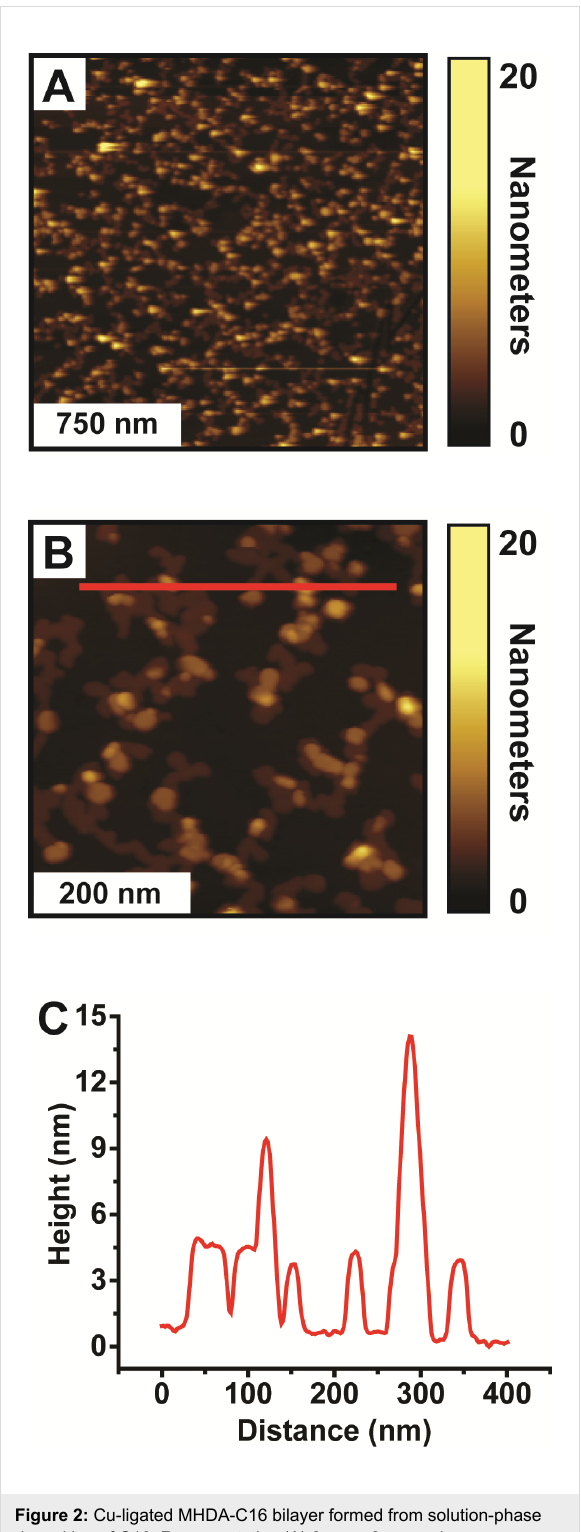
Figure 2: Cu-ligated MHDA-C16 bilayer formed from solution-phase deposition of C16. Representative (A) 2 µm × 2 µm and (B) 500 nm × 500 nm AFM images of a Cu-ligated MHDA-C16 bilayer formed from the solution deposition of MHDA for 18 h, Cu(ClO 4 ) 2 ·6H 2 O for 5 min, and C16 for 1 h. (C) Corresponding cursor profile across the C16